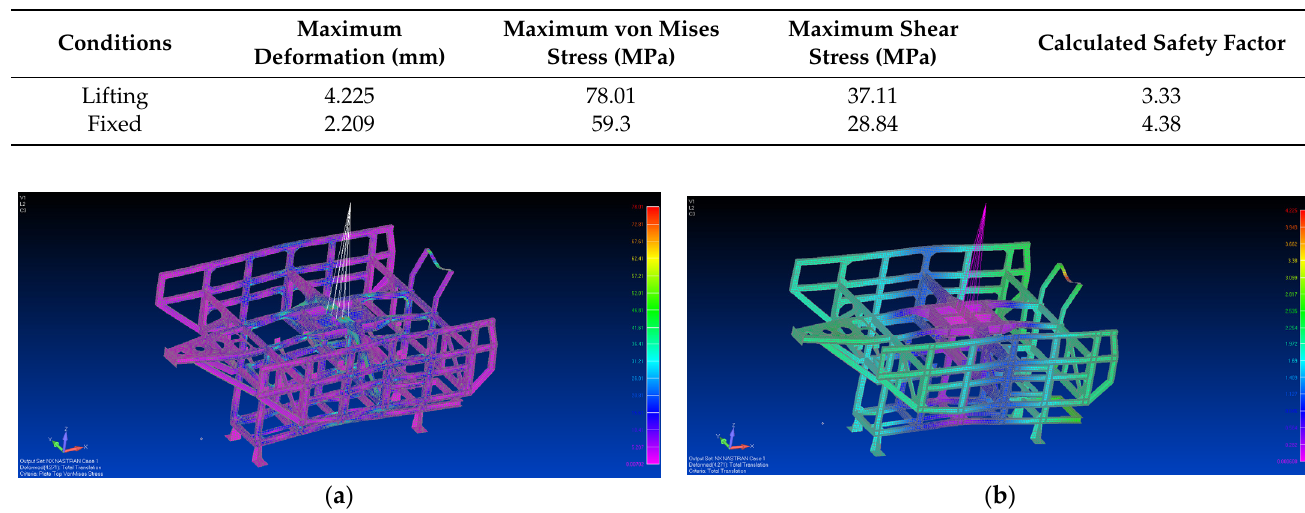
Table 3. FEM results for frame structure.